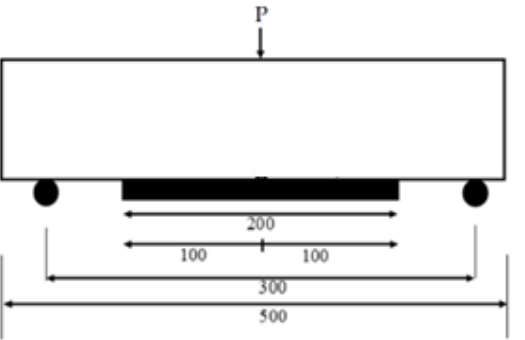
Figure 6. Schematic diagram of the LFC sample geometry and setup for flexural test.